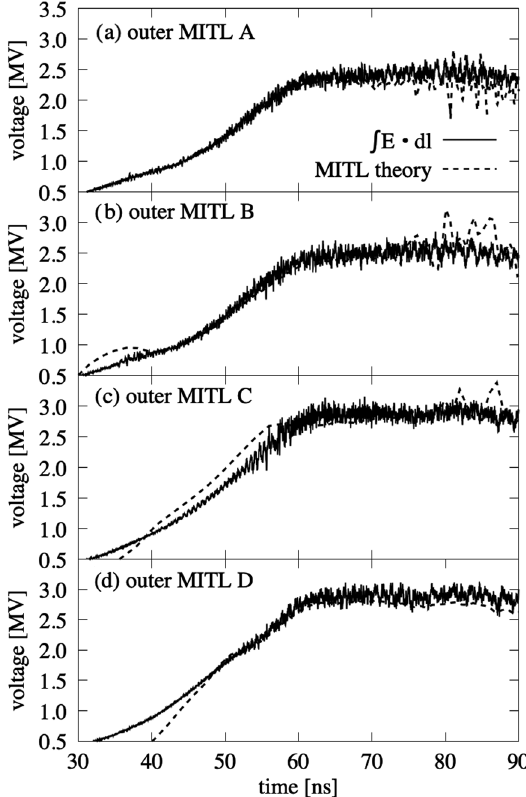
FIG. 6. The measured and simulated currents in the stack and outer MITLs for the Fig. 3(a)